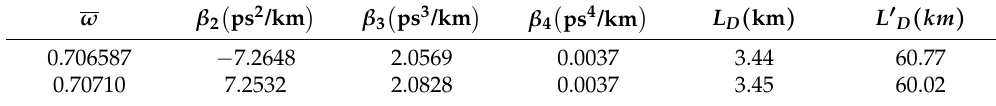
Table 3. Two sets of dispersion data including β 4 .